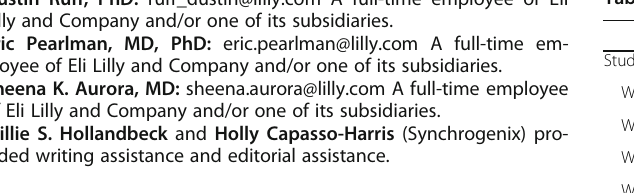
Table 1 (abstract P132). See text for